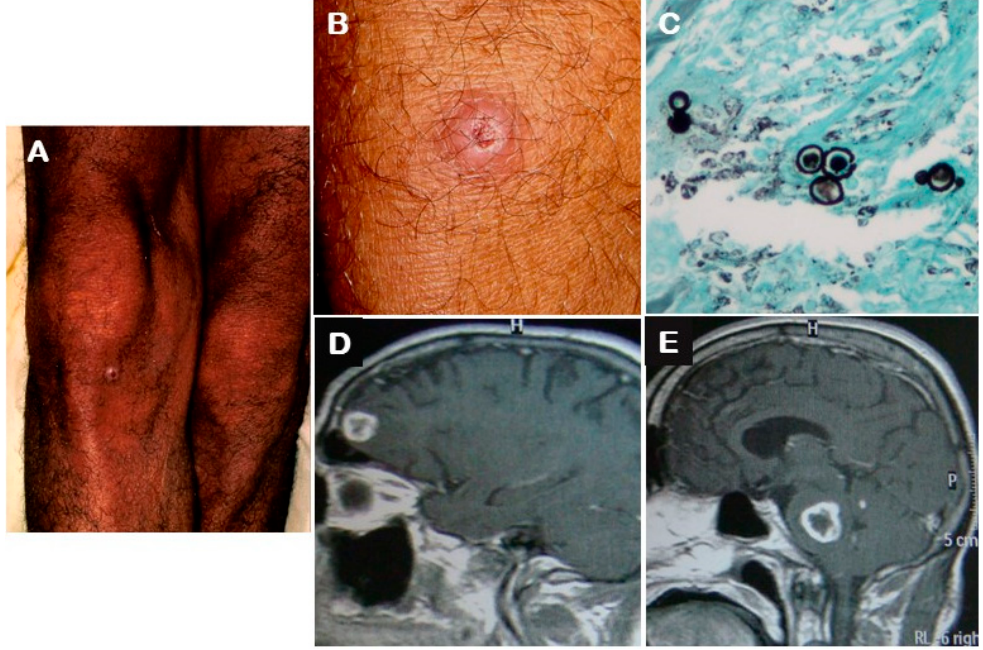
Figure 1. Neuroparacoccidioidomycosis in a patient with the chronic form of the mycosis: ( A ) A small round erythematous nodular skin lesion (around 1 cm) with central depression covered by crust on the right knee of the patient described as case 1; ( B ) Closer view of the lesion described in panel A; ( C ) Histopathological examination (Grocott silver stain) of a fragment of the skin lesion on the knee showing large budding yeast cells of Paracoccidioides sp.; ( D ) Magnetic resonance image showing a hyperintense (T1) round lesion with peripheral contrast enhancement and surrounding edema on the left frontal lobe (2 cm); ( E ) A similar brain lesion on the pons (2.5 cm).